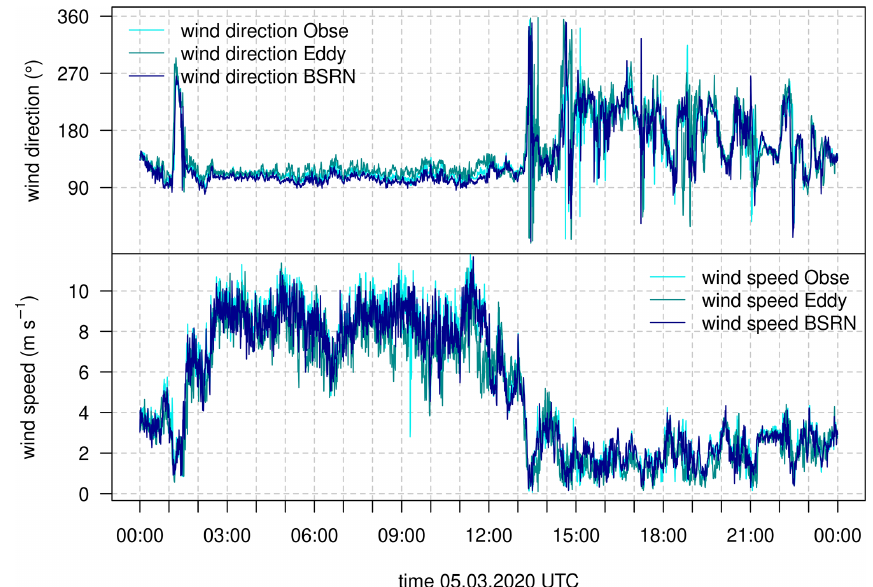
Figure 7. Wind direction and wind speed (temporal average 30s) for all three ultrasonic anemometers at the three towers (OBSE, EDDY, and BSRN) for the 5